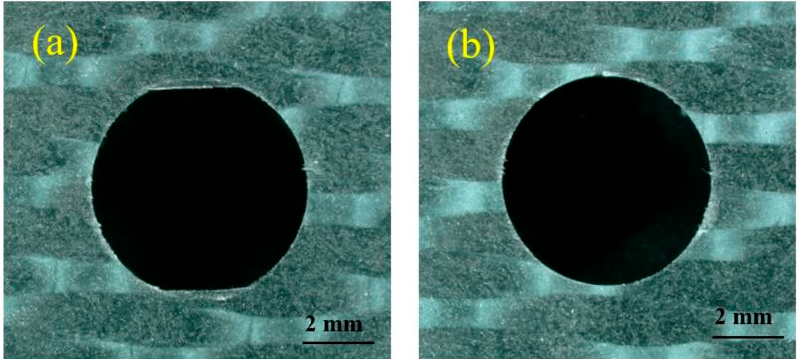
Figure 12. Effect of HF-VAD on the exit delamination at f = 0.075 mm/rev and N = 3000 rpm for ( a ) F = 1500 Hz and ( b ) F = 2150 Hz.